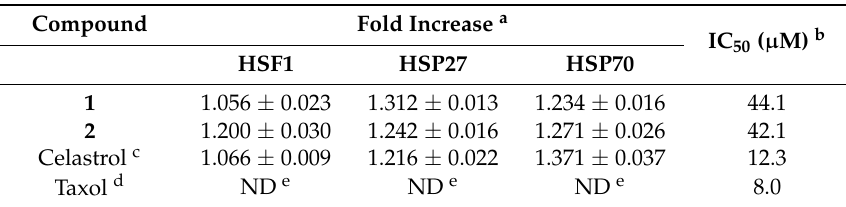
Table 1. Induction of heat shock factor (HSF) 1 and heat shock proteins (HSPs) by compounds 1 and 2 isolated from A. katsumadai